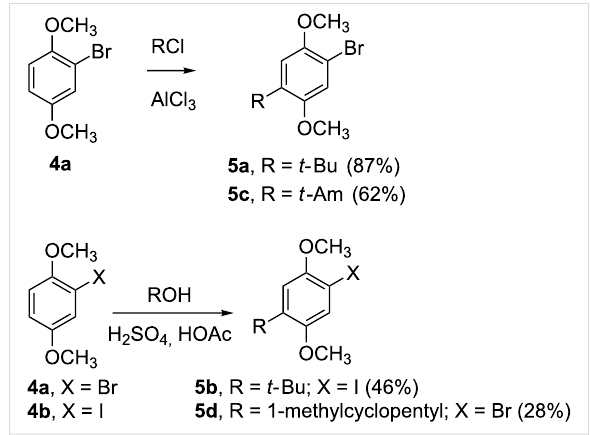
from loading intracellular calcium stores. No other major proteases share the specificity of PSA, which prevents prema- ture inhibitor activation in healthy cells. Moreover, as PSA is deactivated by inhibitors present in the blood serum, potential detrimental effects on other tissues are avoided. Compound 1b was found to be selectively toxic to PSA-producing prostate cancer cells as well as in animal studies at submicromolar con- centrations